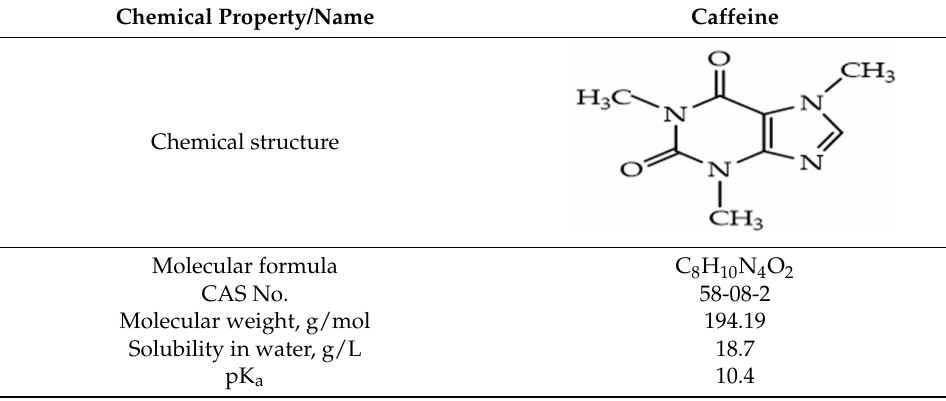
Figure 9. ( a ) Initial pH effect and corresponding apparent degradation rate constant (inset) on Ag-ZnSnO 3 over 10 mg/L caffeine, and ( b ) Dark, photolysis, heat effect with and without catalyst on Ag-ZnSnO 3 over 10 mg/L at initial pH = 7.5. Table 3. Characteristics of Caffeine (CAF) as the tested model CEC